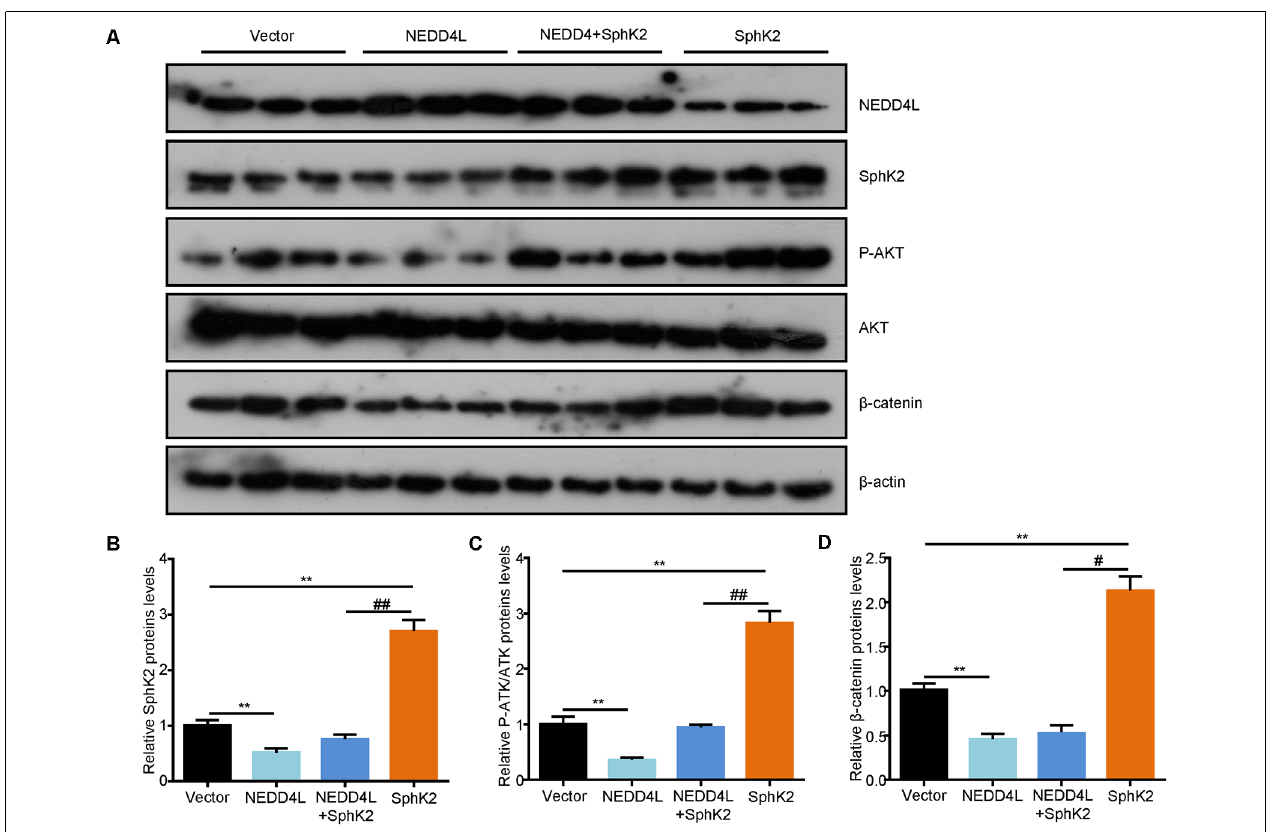
FIGURE 7 | Ubiquitination of SphK2 suppresses glioma growth via AKT/ β -catenin pathway in vivo . (A,B) Total proteins were isolated from tumor tissues and expressions of concerned genes were confirmed by IB analysis with relevant antibodies. (C) Relative protein levels of P-AKT. (D) Relative protein levels of β -catenin. ** P < 0.01 compared with the vector; # P < 0.05, ## P < 0.01 compared with SphK2 overexpression